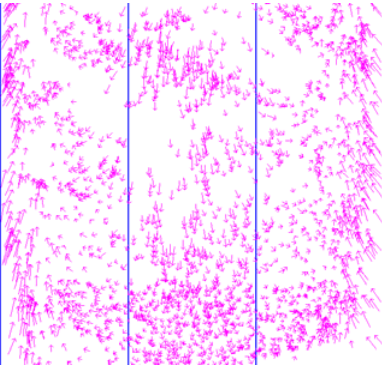
(a) Image point residues with scheme 11 in Table 3